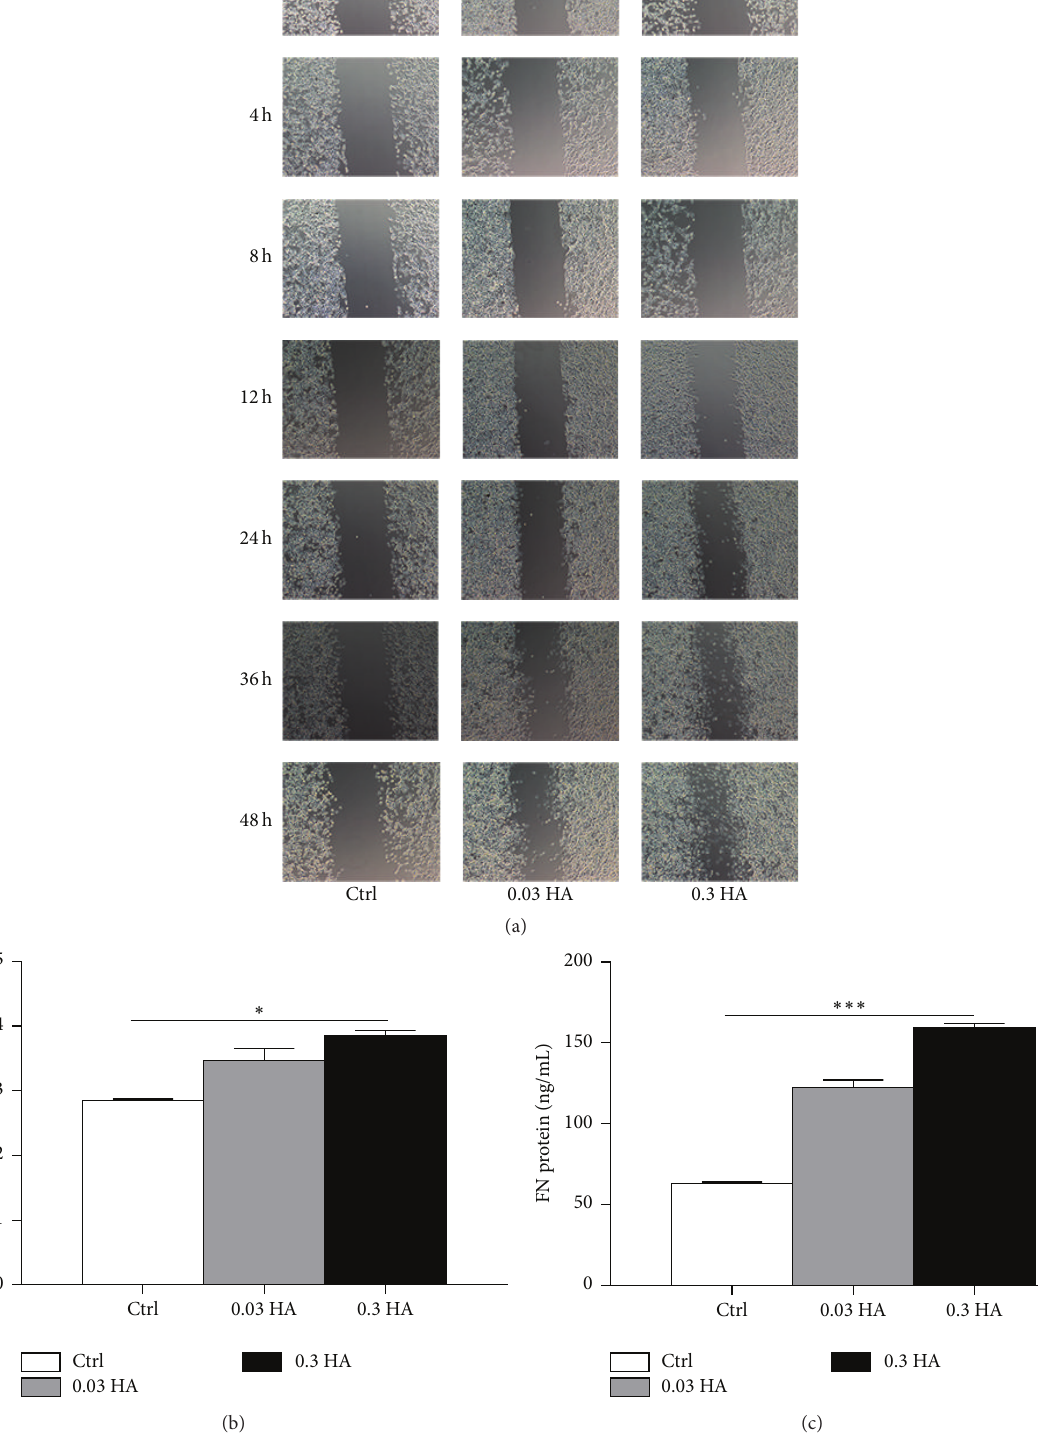
Figure 1: Hyaluronate promoted cell migration and increased the expression of repair factors. Microscopic images (a) of the repair of HCECs in the control, 0.03 HA, and 0.3 HA groups. CD44 (b) and FN (c) protein levels were examined in the control, 0.03 HA, and 0.3 HA groups. Magnification: × 20. The data are the mean ± SEM and represent individual experiments, each including 5 samples/group/time. ∗ 𝑝 < 0.05 ; ∗∗∗ 𝑝 < 0.001